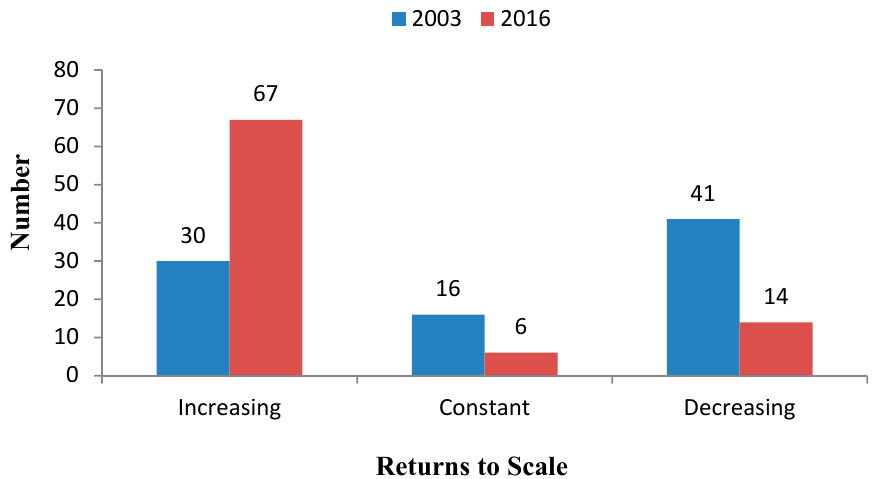
Figure 4. Classifications of SOFEs’ Returns to Scale. Note: calculated based on data from the Chinese Figure 4 . Classifications of SOFEs' Returns to Scale. Note: calculated based on data from the Chinese Forestry Statistical Yearbook and the China Statistical Yearbook . Forestry Statistical Yearbook and the China Statistical Yearbook .